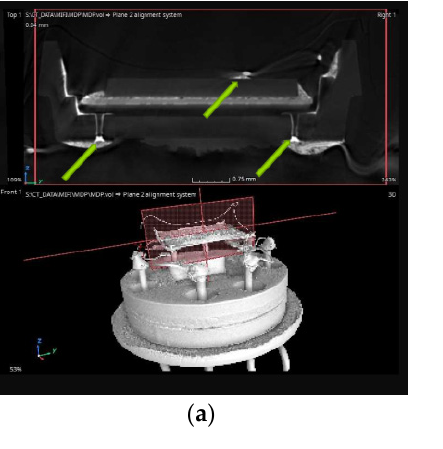
Figure 7. The reverse design of a 3D digital model of a metal–ceramic sensor package mounted on a TO-8 package holder: ( a ) arrows indicate soldering points; ( b ) the sections show the via holes in the ceramic base and the partial filling of the via holes by solder.